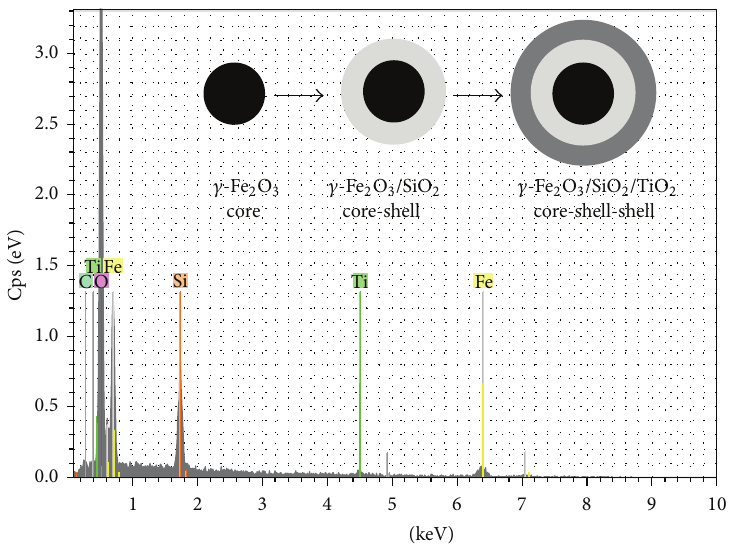
Figure 5: Energy-dispersive X-ray diffraction spectrum (EDX) of the ferromagnetic nanoparticles.